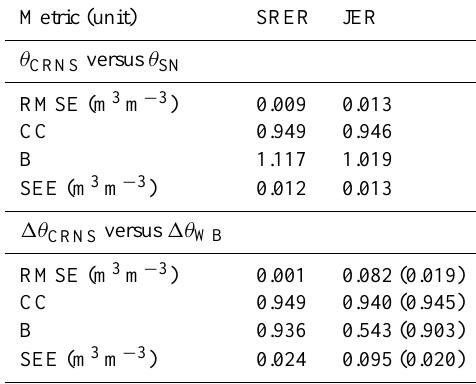
Table 4. Statistical comparisons of CRNS method with distributed sensor network and water balance estimates based on the standard error of estimates (SEE), root mean square error (RMSE), bias (B), and correlation coefficient (CC), described in Vivoni et al. (2008b). Values in parentheses for JER indicate metrics when large rainfall events are excluded.